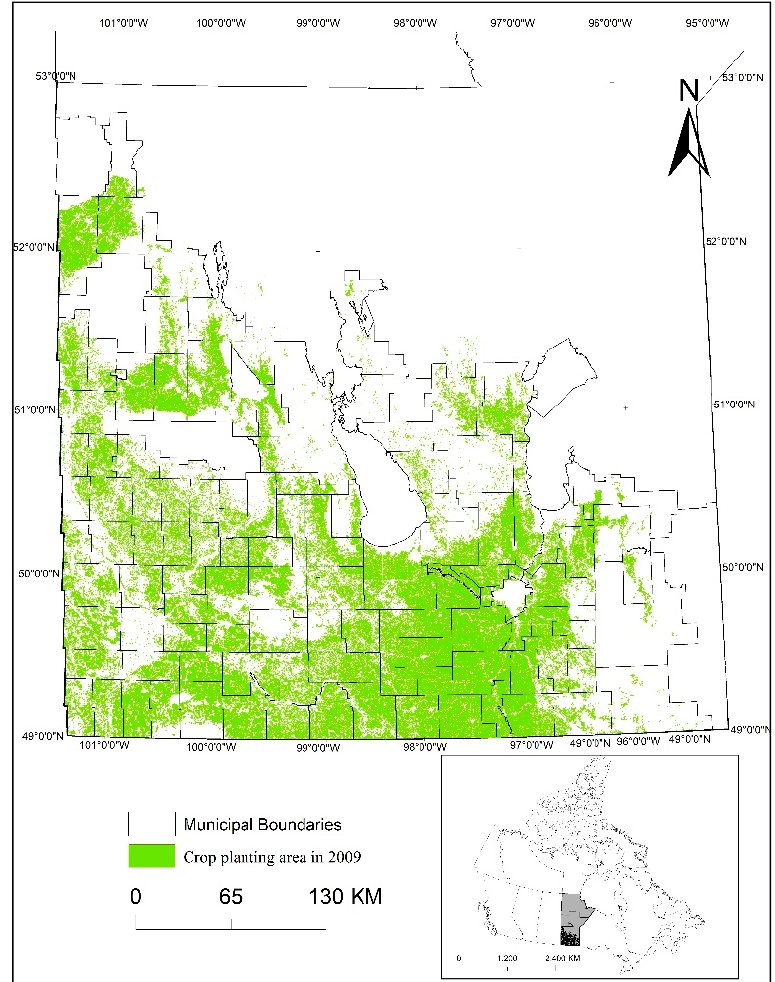
Figure 1. The study area in the Province of Manitoba, Canada, and the distribution of annual cropland in 2009. The subset figure highlights the location of the study area within Canada.